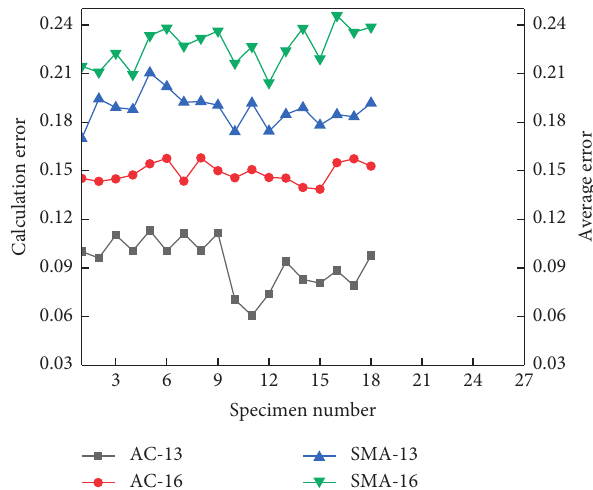
Figure 8: Applicability analysis of the Brown model.